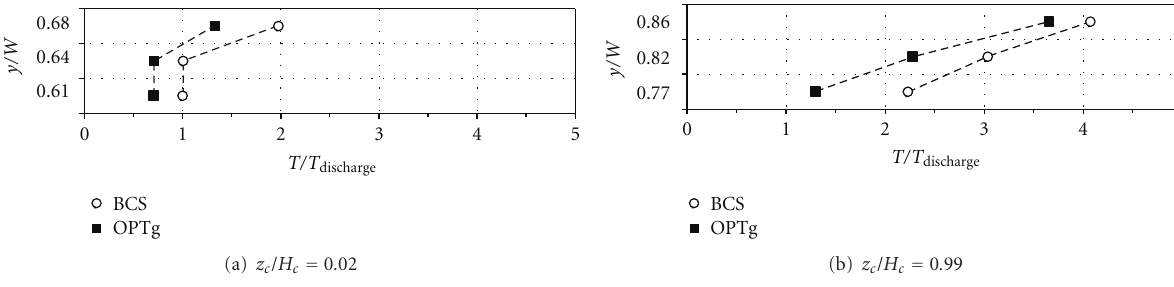
to the analysis of the thermal behaviour influenced by fans velocity, holes density and distribution on the PBP; DAG and RAG angles; and flow deflectors inside the internal